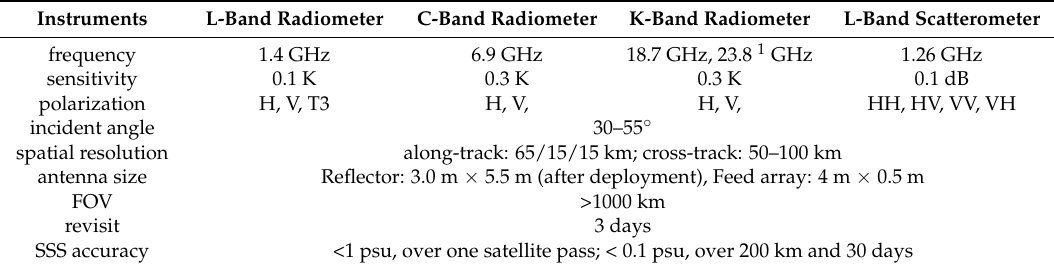
Table 1. The main system specifications of